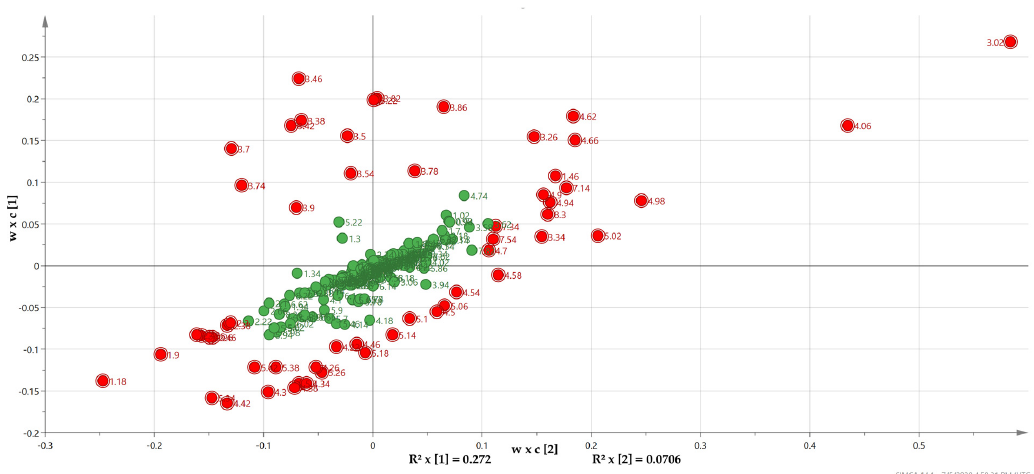
Figure 2. Corresponding loading plot of PLS-DA with a confluence of variable importance in the projection (VIP) results (highlighted as red). The loading plot reveals the important regions in the spectra (metabolites) are responsible for the group clustering shown by the score plot. These regions matched those identified by the VIP plot (VIP > 1) and lead to the separation of the groups.